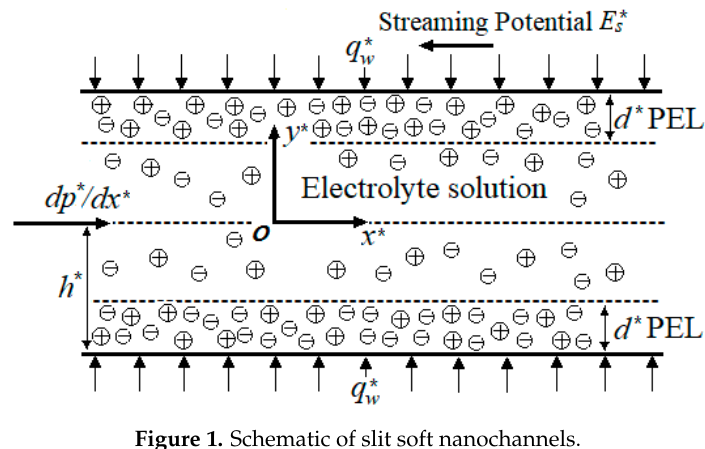
Figure 1. Schematic of slit soft nanochannels.